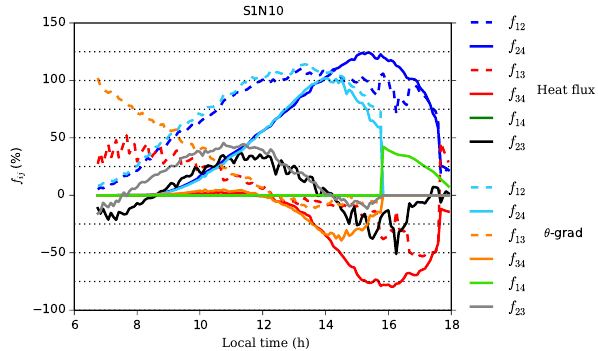
Figure 9. As in Fig. 4d, but comparing normalized bulk tracer mass fluxes for simulations S1N10 based on the heat-flux criterion (dark colours) and on the θ -gradient criterion (light